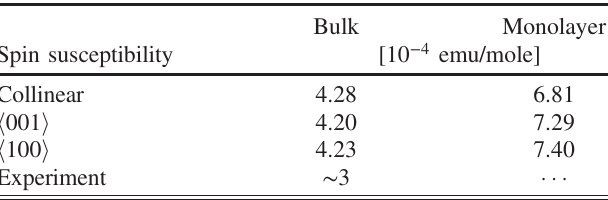
TABLE I. Spin susceptibility of the bulk and monolayer structures obtained from collinear and noncollinear calculations with the spin quantization axis parallel to the c axis, h 001 i , and the spin quantization axis along the x direction, h 100 i . The calculated susceptibility along h 100 i , h 010 i , and h 110 i are equivalent. The experimental value of χ , obtained from Ref. [33], is for a magnetic field applied parallel to the c axis ( h 001 i ). The experimental value of χ for monolayer NbSe 2 to our knowledge has not been reported